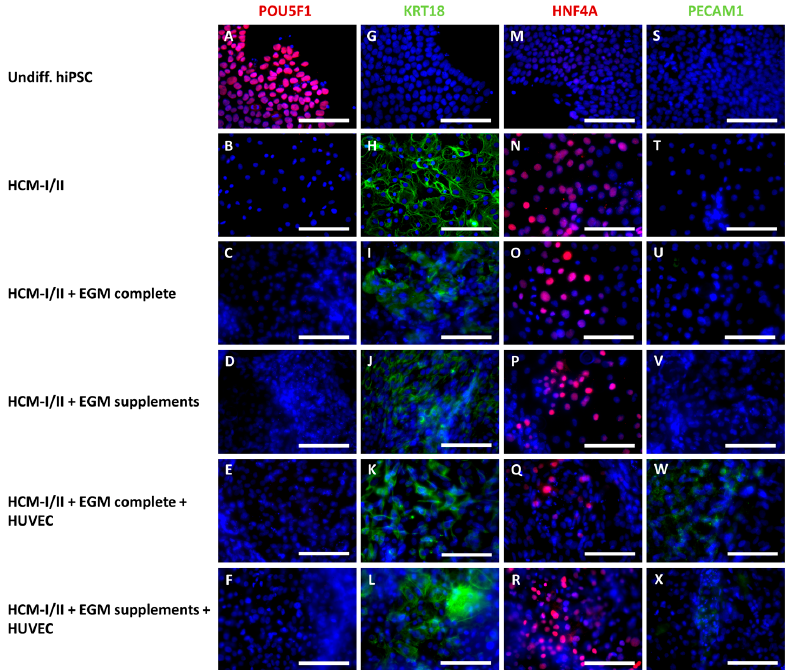
Figure 6. Immunocytochemical staining of human induced pluripotent stem cells (hiPSC) after hepatic differentiation in different media compositions and/or in co-culture with human umbilical vein endothelial cells (HUVEC). Differentiation of definitive endodermal cells was performed over 14 days using hepatocyte culture medium (HCM-I/II), a 1:1 mixture of hepatocyte culture medium and endothelial cell growth medium, consisting of basal medium and supplements (HCM-I/II + EGM complete) or HCM enriched with endothelial cell growth supplements (HCM-I/II + EGM supplements) with or without HUVEC addition. The pictures show the pluripotency marker POU class 5 homeobox 1 (POU5F1, A–F ); the hepatocyte markers cytokeratin 18 (KRT18, G–L ) and hepatocyte nuclear factor 4 α (HNF4A, M–R ) and the endothelial cell marker platelet endothelial cell adhesion molecule 1 (PECAM1, S–X ). Nuclei were counter-stained with Dapi (blue). Scale bars correspond to 100 µ